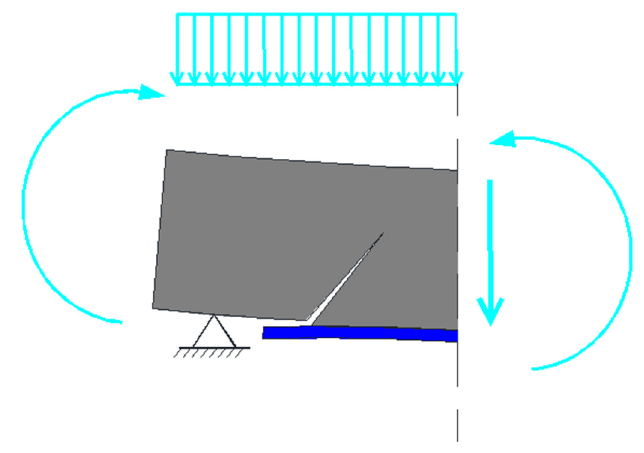
Figure 4. Debonding due to vertical cracks.